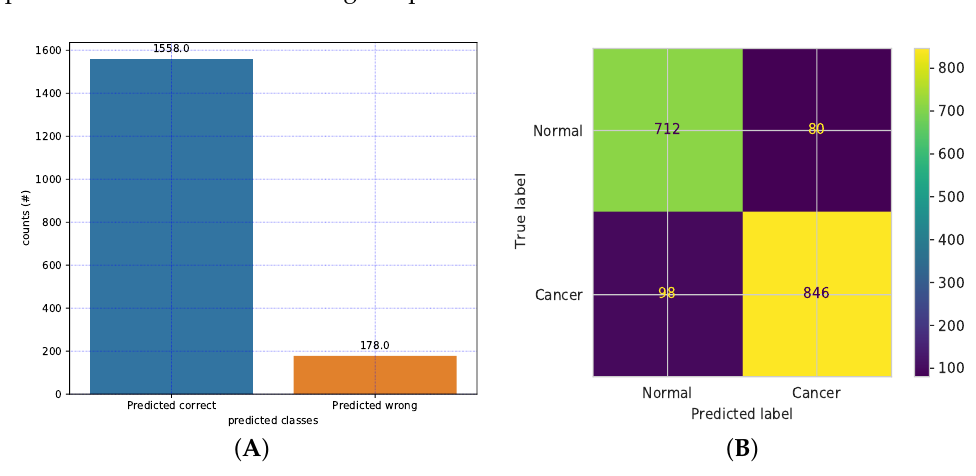
Figure 7. Overall prediction accuracy. ( A ) Cancerous class prediction. ( B ) Confusion